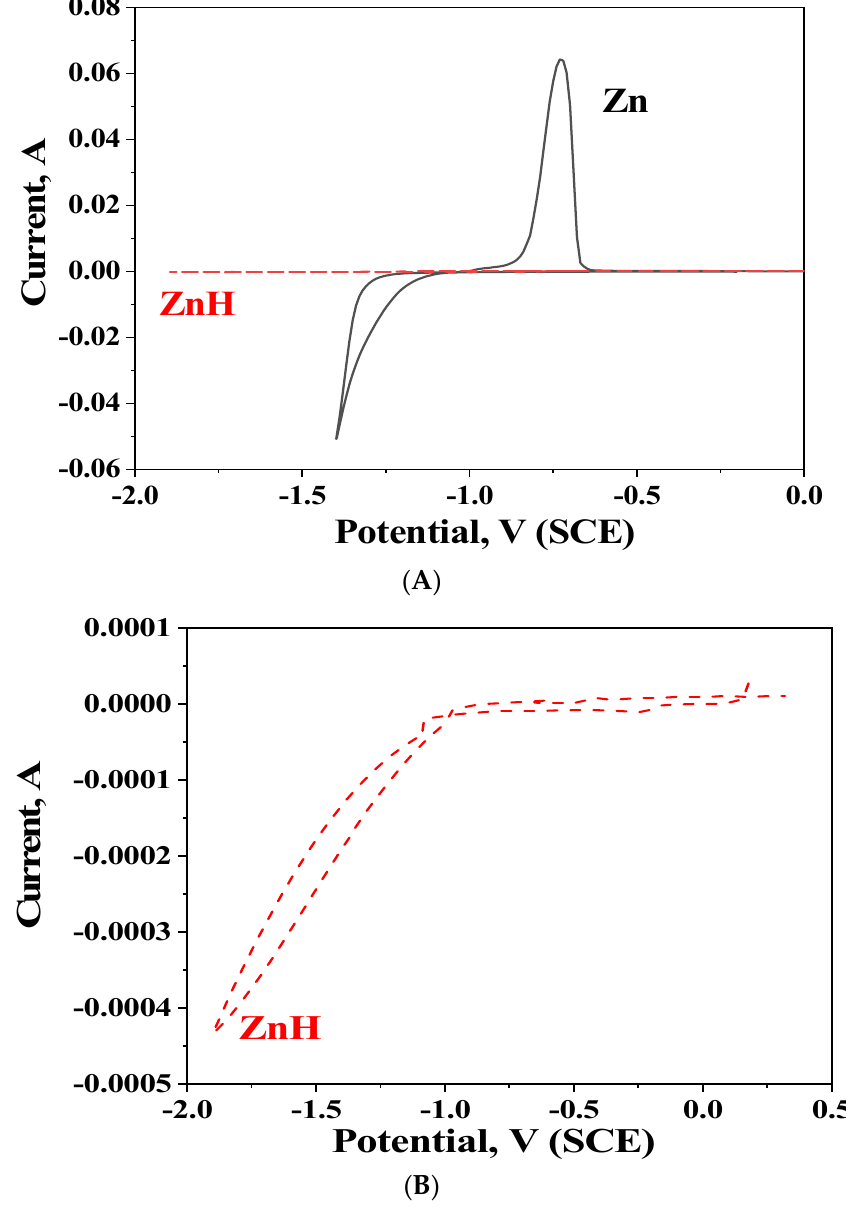
Figure 4. ( A ) Cyclic voltammetry of hybrid (ZnH) and ordinary zinc coatings. ( B ) Cyclic voltammetry of hybrid